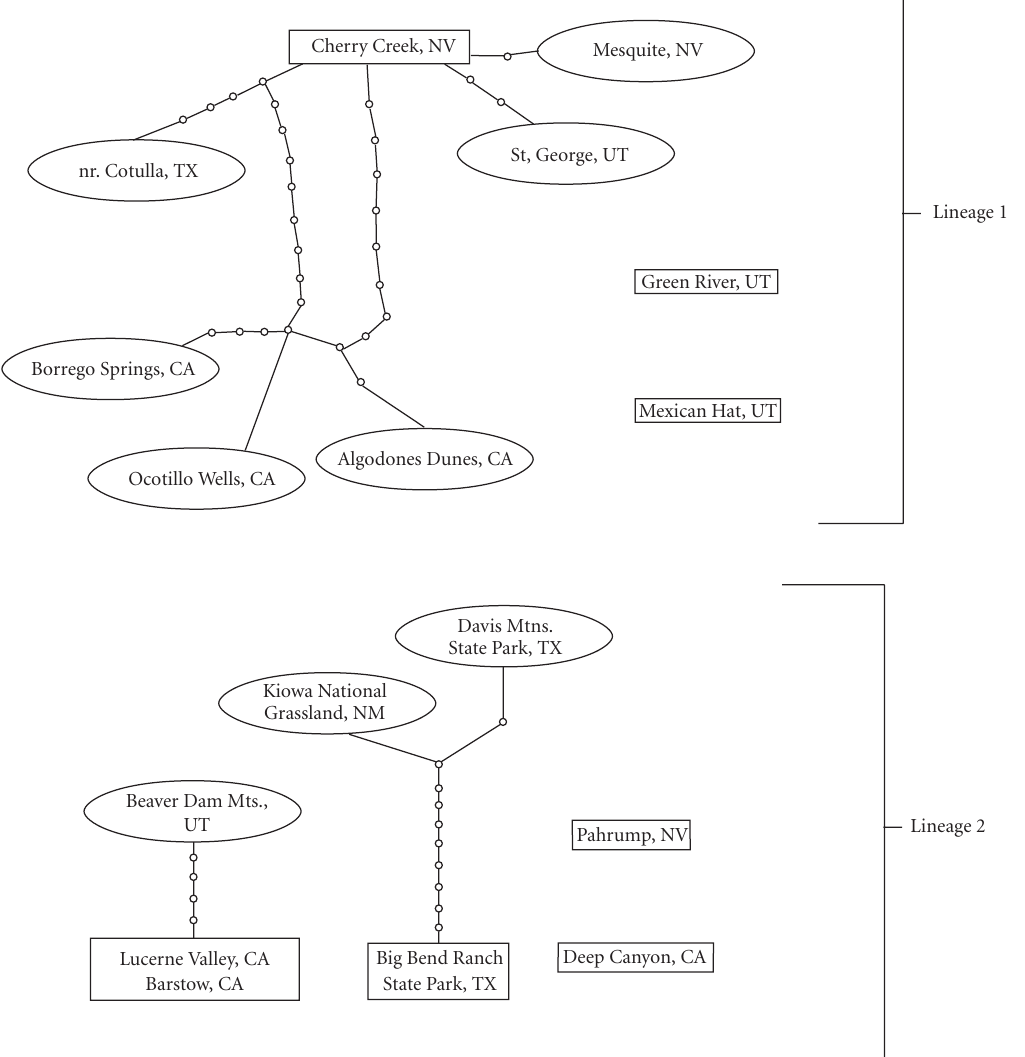
Figure 4: Haplotype networks based on the aligned COI data set. Populations are named based on their collection locality, and populations corresponding to Lineage 1 and Lineage 2 from Figure 3 are marked. Haplotypes surrounded by a rectangle were estimated to be the ancestral haplotype for